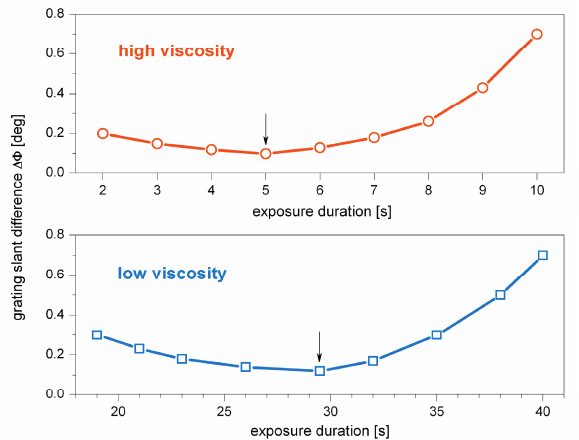
Figure 4. Influence of the exposure duration on the grating slant difference: ΔΦ ( t exp ) for low viscosity (below, blue squares) and high viscosity (on top, orange circles). The